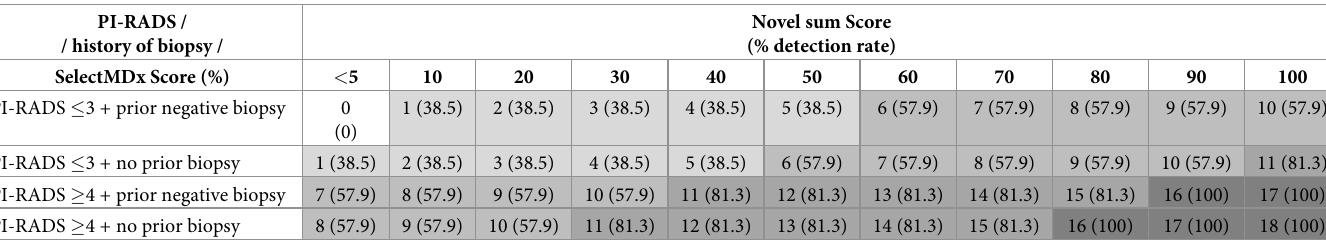
Novel sum Score (% detection rate)